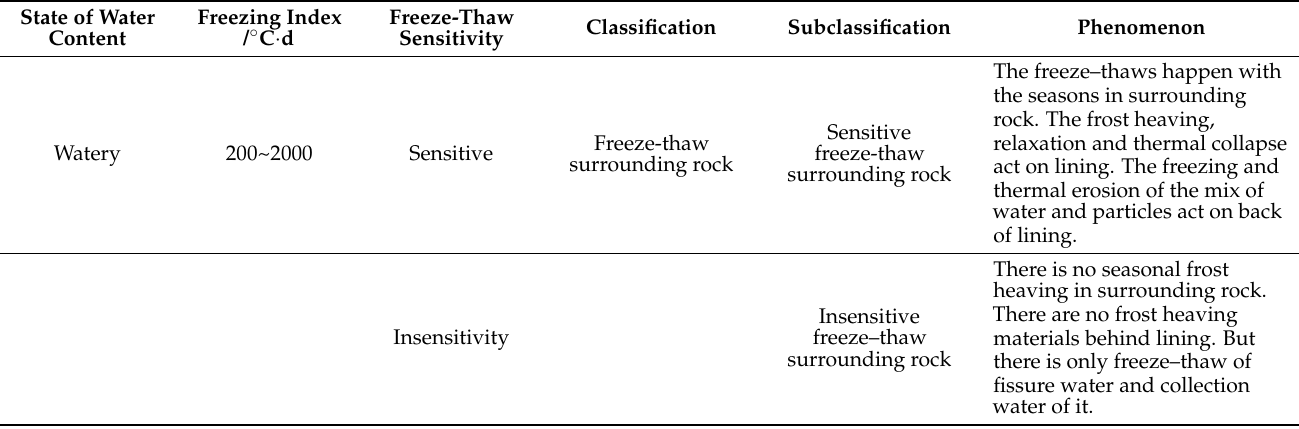
Table 5. Classification of surrounding rock in cold